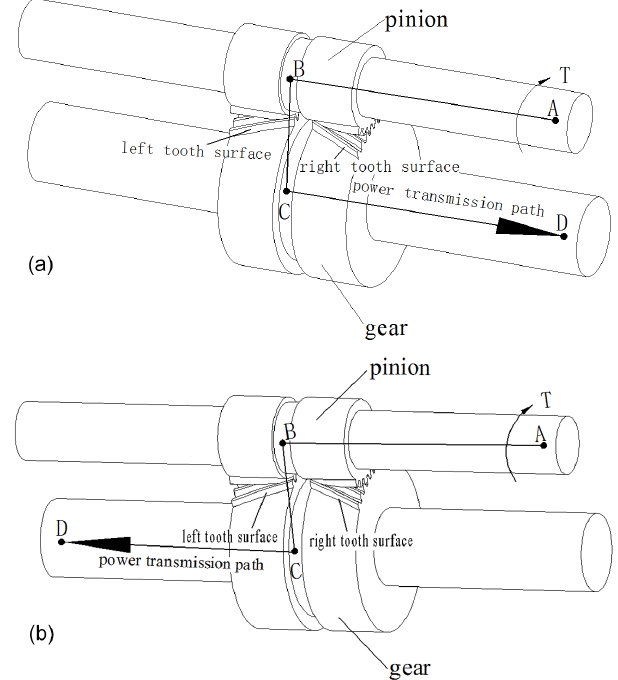
Figure 12. Schematic diagram of two different power flows. (a) U - shaped power flow. (b) Z -shaped power